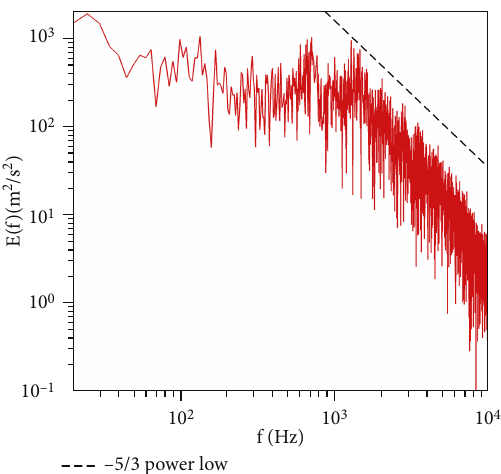
Figure 3: Power spectrum of turbulent kinetic energy.